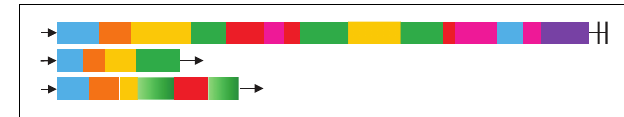
FIGURE 4 | Skill sequences of three children in addition from 0 to 100. Colors are consistent with Figure 3B . Users 2 and 3 passed all skills in the range, while user 1 did not pass this range within the training period. The length of the rectangles indicates the number of